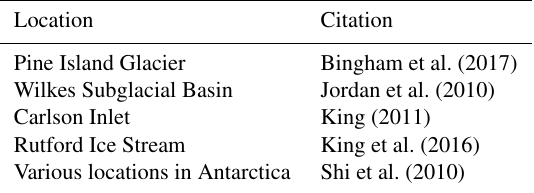
Table 1. High-resolution ground-truth datasets from ice- penetrating-radar surveys (collectively labelled as y ) used to train the DeepBedMap model. Training site locations can be seen in Fig.